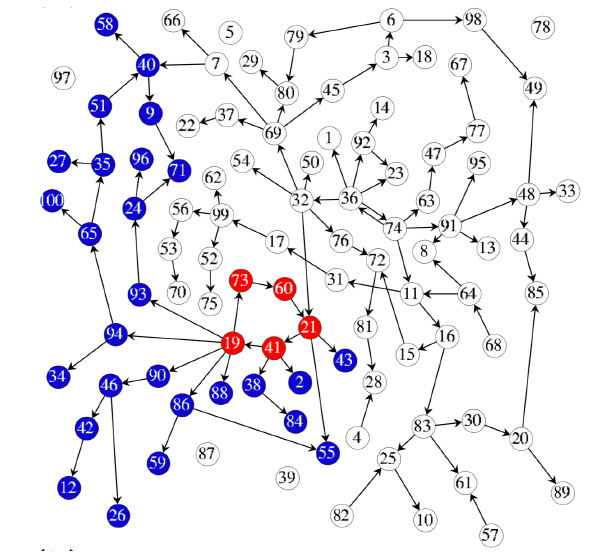
Figure 6. Jain and Krishna’s Autocatalytic Sets Red nodes belong to the core of the dominant autocatalytic set of the graph, blue nodes to its periphery, and white nodes are outside the dominant autocatalytic set. This diagram shows run 6062 in the computational modelling of the graph (Jain & Krishna, 2003). Reproduced by kind permission of Wiley publishers and the